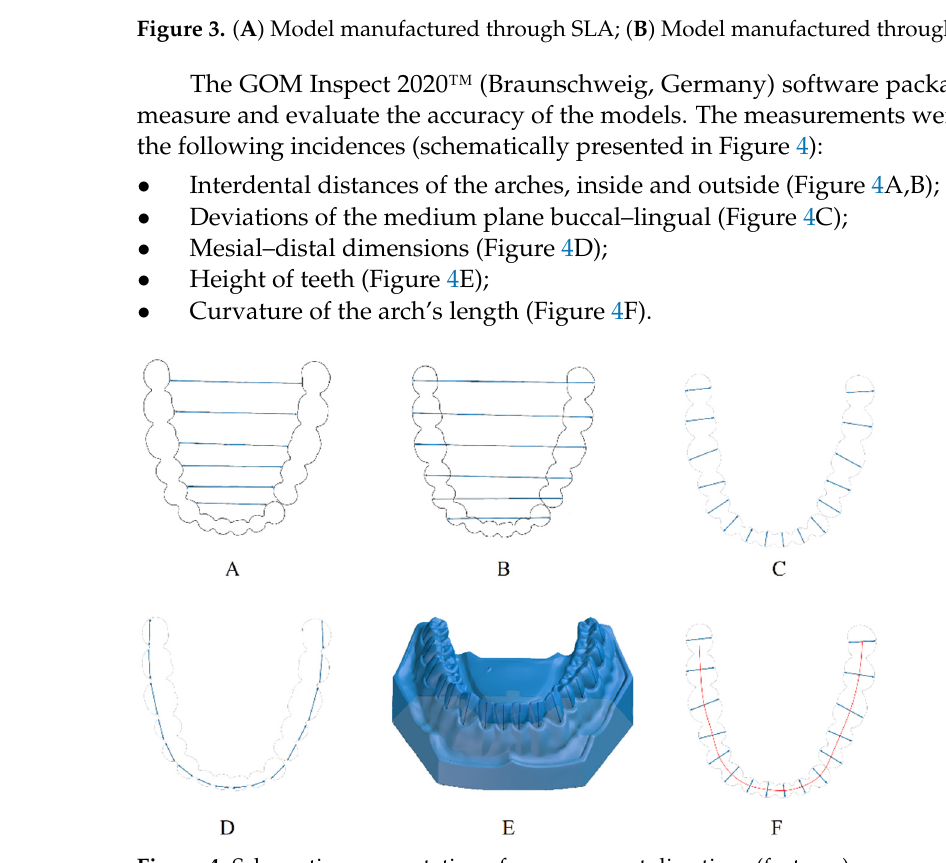
Figure 4. Schematic representation of measurement directions (features).